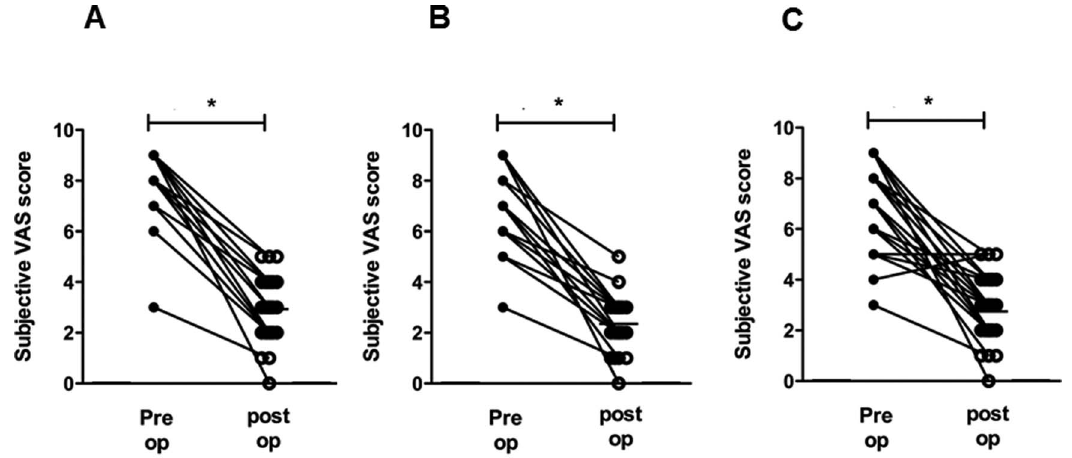
Figure 5. Changes in visual analog scale (VAS) score for subjective symptoms, such as nasal obstruction (A), snoring (B), and daytime somnolence (C), before and after nasal surgery. * : p , 0.05 when comparing the pre-and post-operative values.